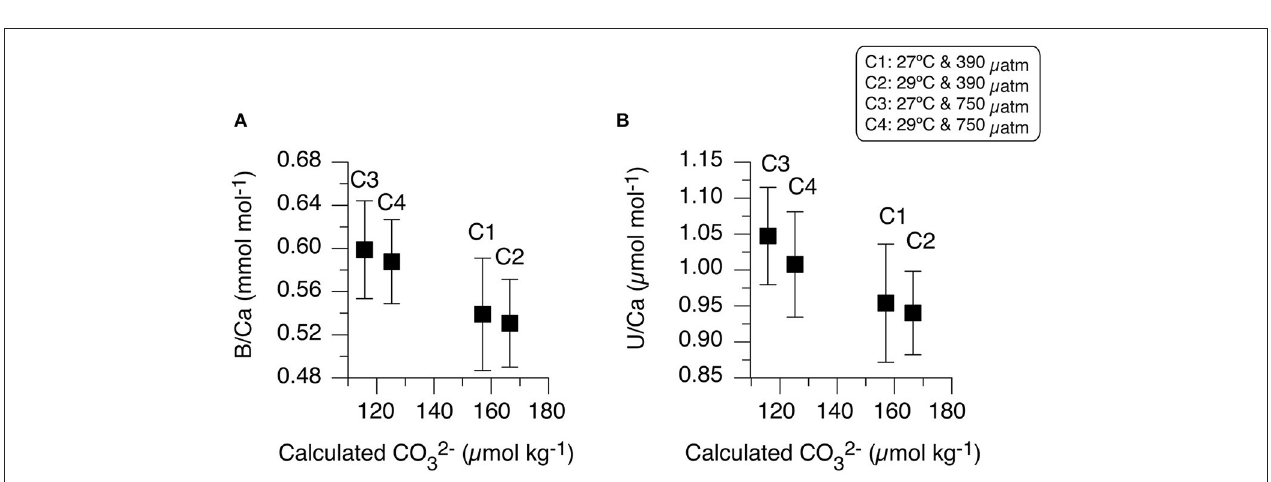
FIGURE 7 | Measured B/Ca and U/Ca ratios relationship to calculated seawater [CO 2 − 3 ]. Mean and 1 σ standard deviation of (A) B/Ca (mmol mol − 1 ) and (B) U/Ca ( µ mol mol − 1 ) in primary polyp A. millepora juvenile coral in each of the four experimental conditions comparison to calculated seawater carbonate ion (CO 2 − 3 ) from CO2SYS ( Table 1 ).